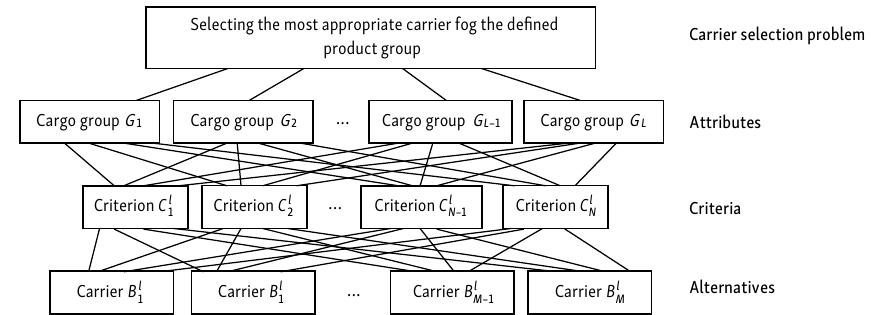
Figure 2. Structure of carrier selection problem (source: own contribution)